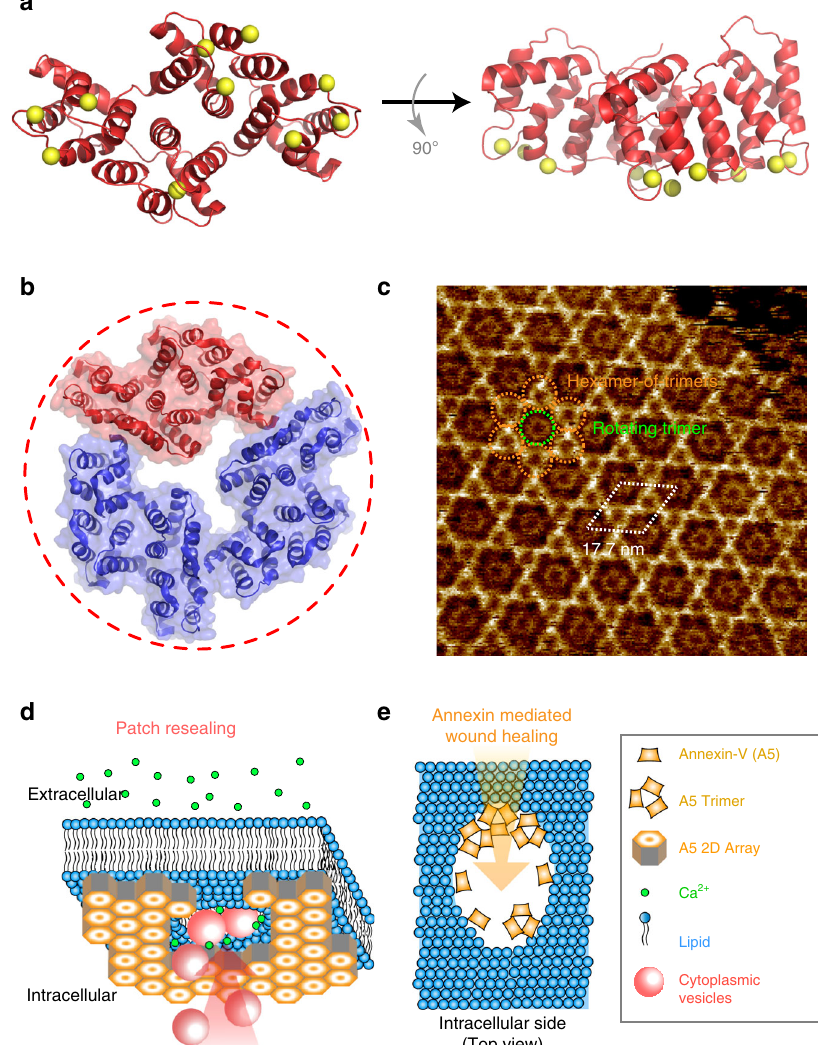
Fig. 1 Structure, supramolecular assembly, and proposed membrane-repair mechanisms of A5. a Bottom view (left) and side view (right) of A5 structure (PDB: 1A8A) with bound Ca 2 + (yellow spheres). The membrane-facing side of the protein is slightly convex (right). b Top-view of A5 trimer, one monomer is colored as in a . c High-resolution HS-AFM image of A5 lattice on a PS-rich membrane. The lattice consists of hexamers-of-trimers ( p 6-trimers) forming a honeycomb pattern; in the center of each honeycomb resides an A5 trimer that displays rotational freedom (non- p 6-trimer). The unit cell ( a = b = 17.7 nm, γ = 60°; white dashed rhomboid) houses 2 p 6-trimers and 1 non- p 6-trimer. d , e Proposed membrane-repair mechanisms: patch resealing ( d ) suggests that the formation of A5 2D-lattices, triggered by the Ca 2 + in fl ux, stabilizes the membrane near lesions, followed by membrane resealing through fusion of intracellular vesicles. Annexin-mediated resealing ( e ) proposes that A5 assemblies along the edge of lesions provides local surface tension leading to membrane